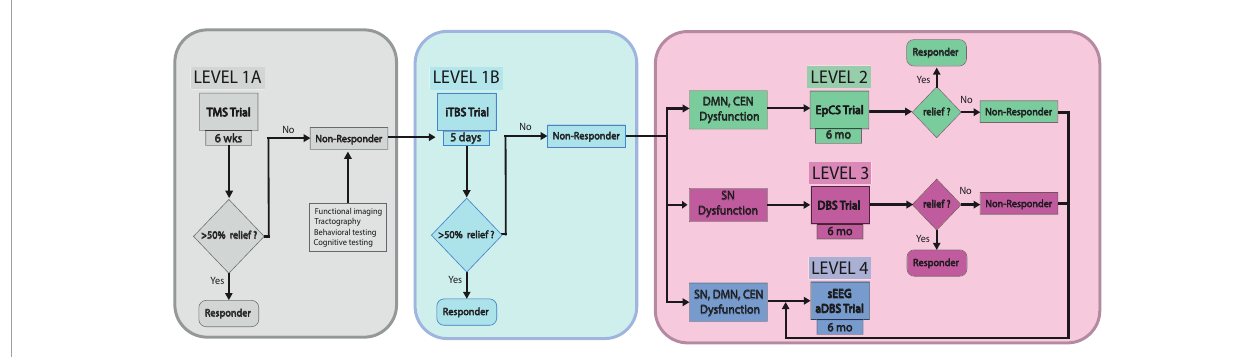
FIGURE1 TRD neuromodulation clinical pathway. This schematic depicts the proposed stepwise pathway for optimizing individualized management of treatment-resistant depression sEEG, stereotactic electroencephalography; aDBS, adaptive deep brain stimulation.